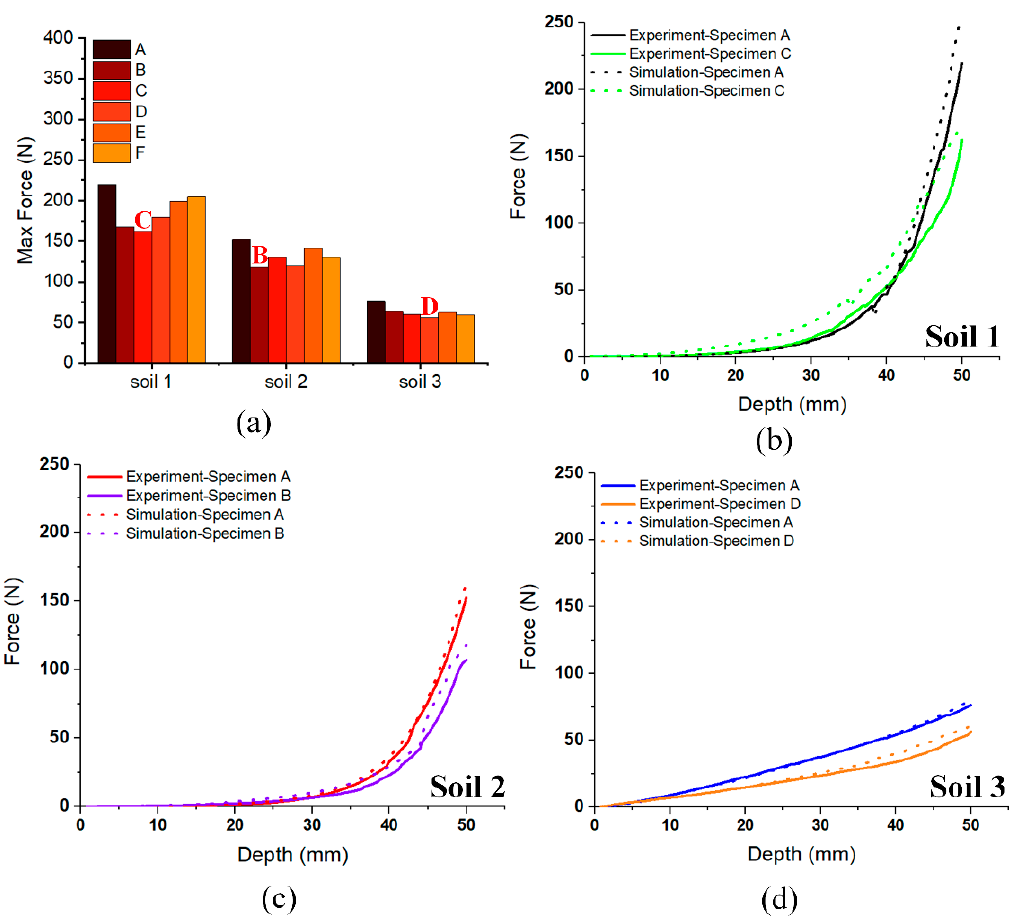
Figure 4. ( a ) The max force of experiments and; The depth-force curves of ( b ) specimen A and C penetrating soil 1, ( c ) specimen A and B penetrating soil 2, and ( d ) specimen A and D penetrating soil 3 in experimental and simulation